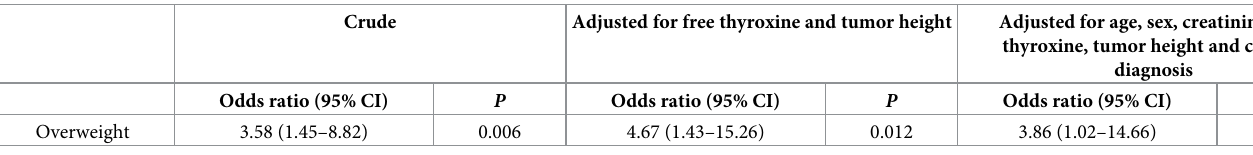
thyroxine, tumor height and clinical diagnosis